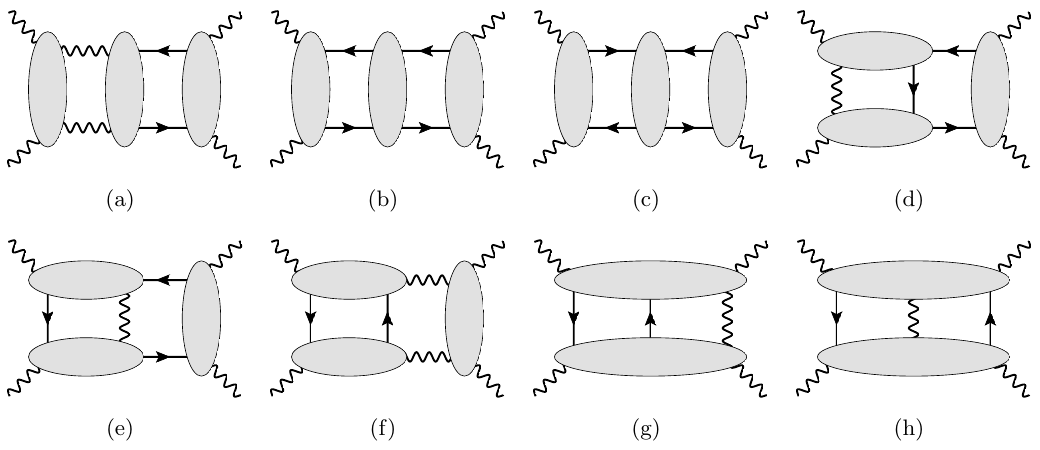
Figure 4 . The eight two-loop spanning cuts involving hypermultiplets required at four points. All exposed propagators are understood as being taken on shell. Notice that cuts (b) and (c) di(cid:11)er by the routing of fundamental hypermultiplets on the right-hand